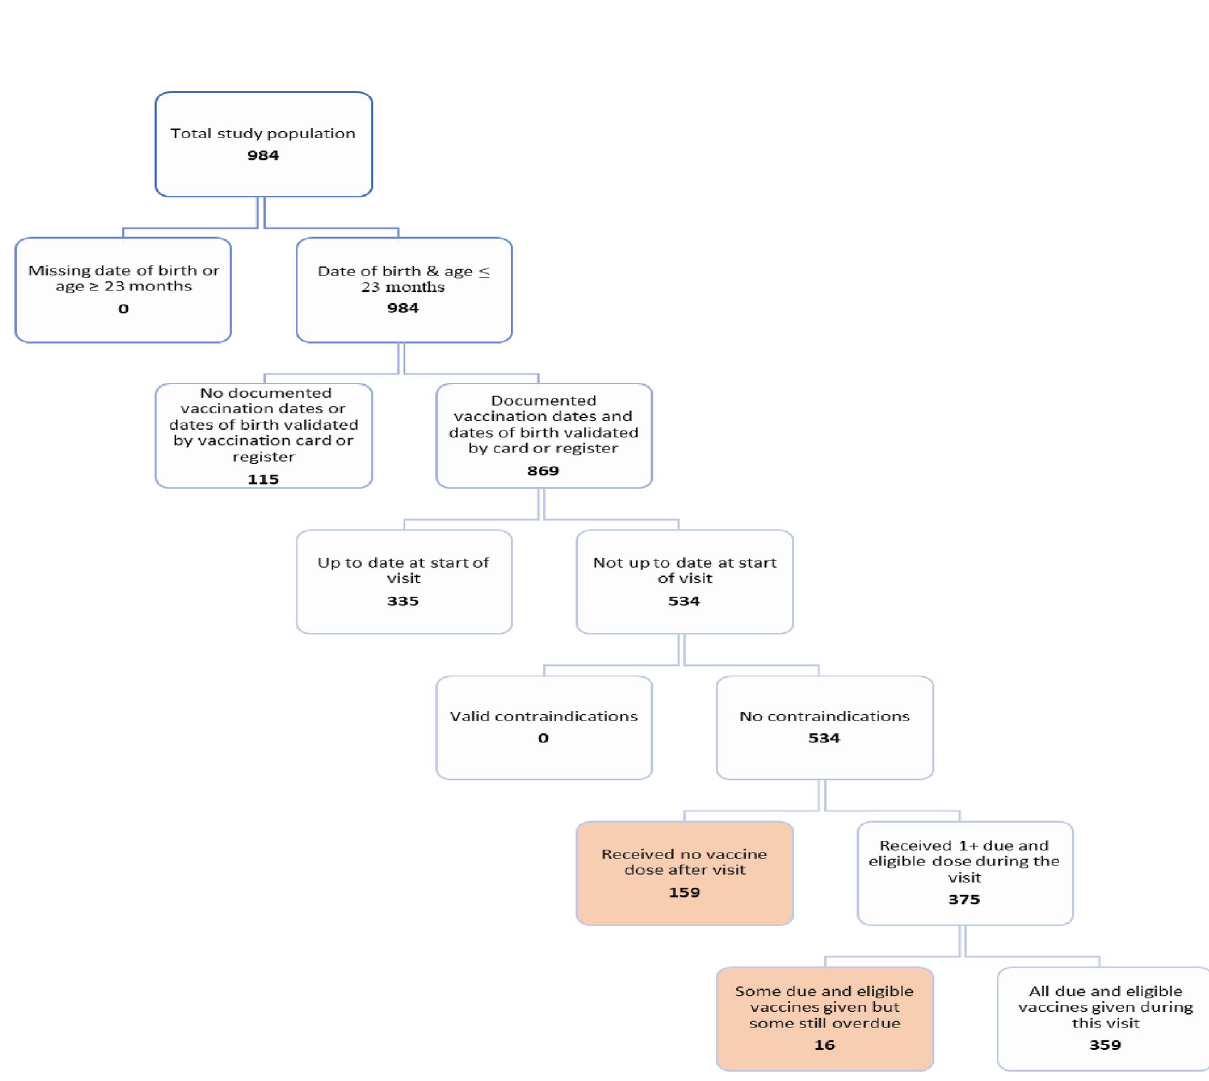
Fig 2. Health facility–based flow-chart for determining missed opportunities for vaccination (MOV) 1 , Ondo State, Nigeria, 2019. 1 Missed opportunity for vaccination (MOV): contact with health services by a child (or adult) who is eligible for vaccination (unvaccinated, partially vaccinated/ not up-to-date, and free of contraindications to vaccination), which does not result in the individual receiving all the vaccine doses for which he or she is